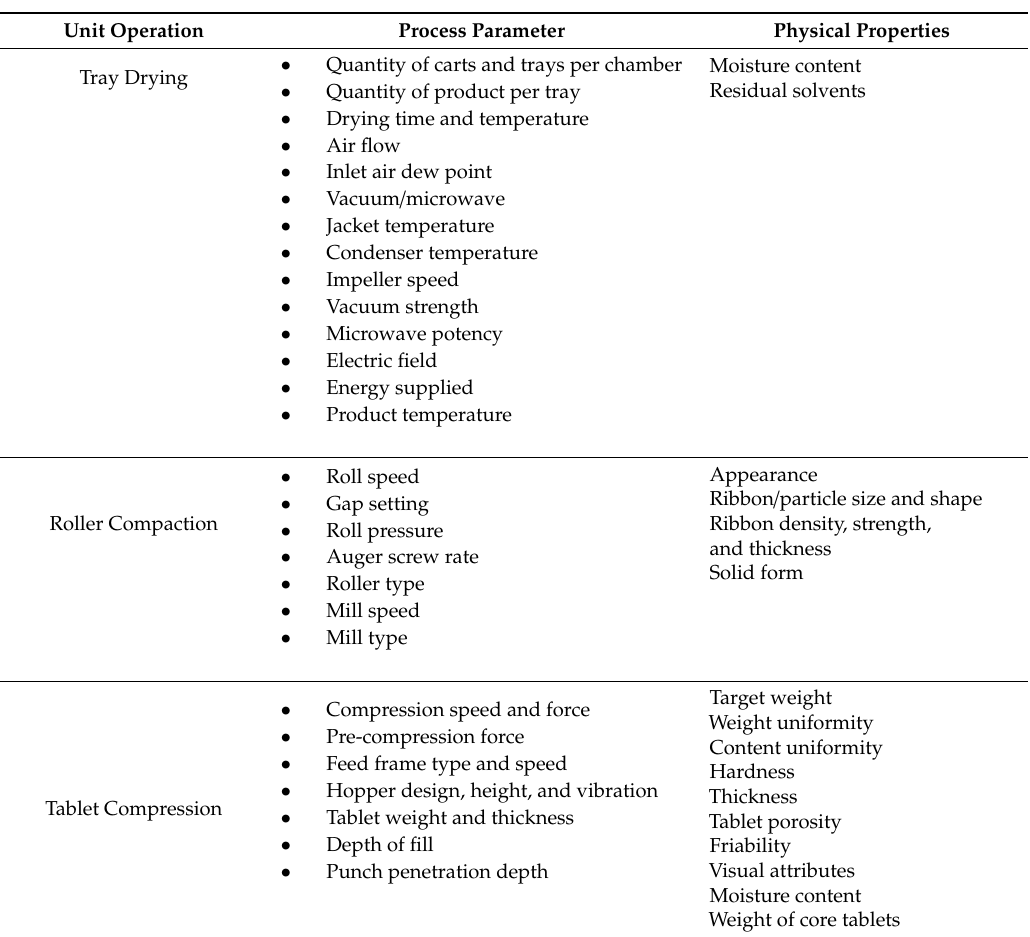
Table A2. Tablet Processing Parameters